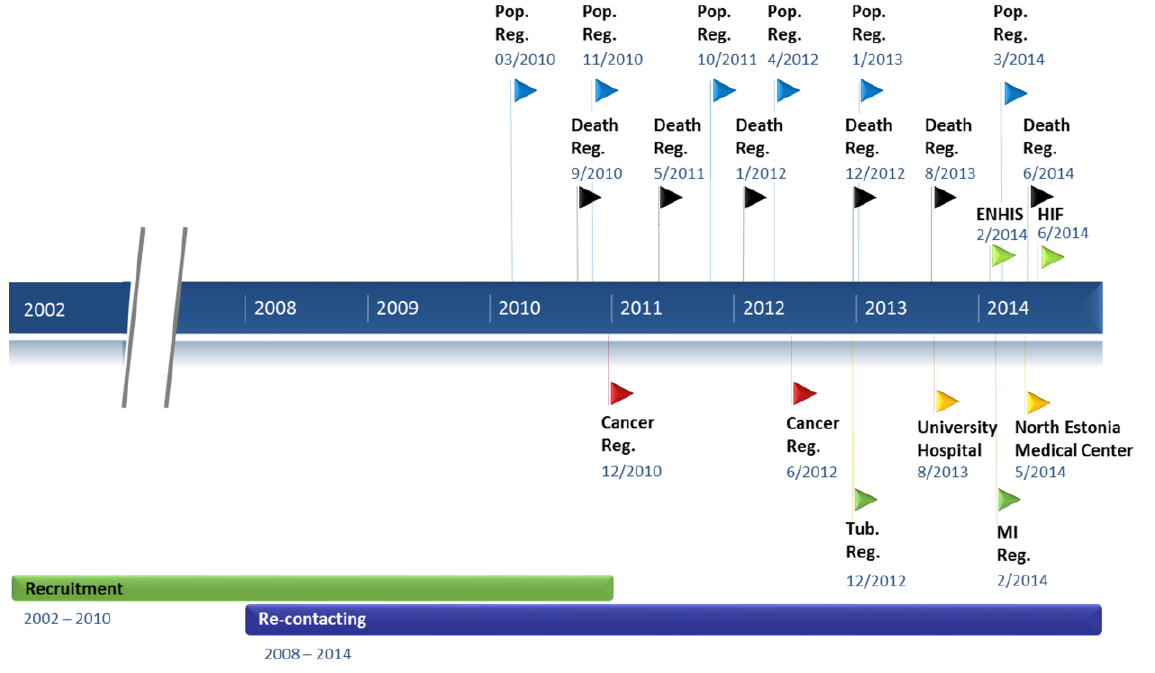
Figure 1. Timeline of the data collection procedures. The timeline showing the recruitment period, re-contacting projects, and frequency and timing of linking with registries and